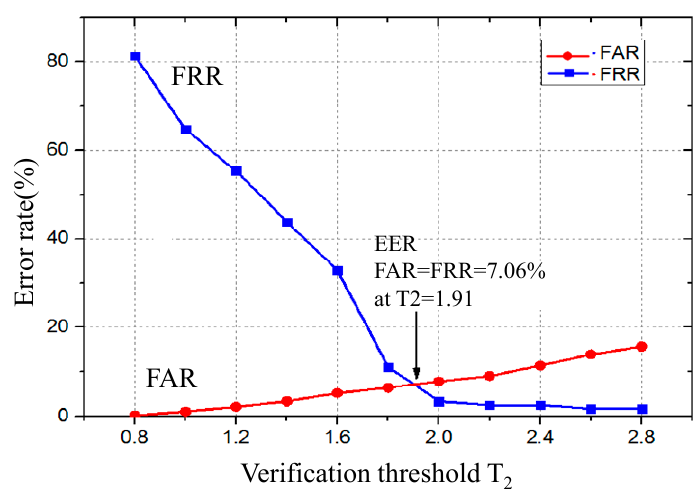
Figure 11. FAR and FRR for different verification threshold T 2 .